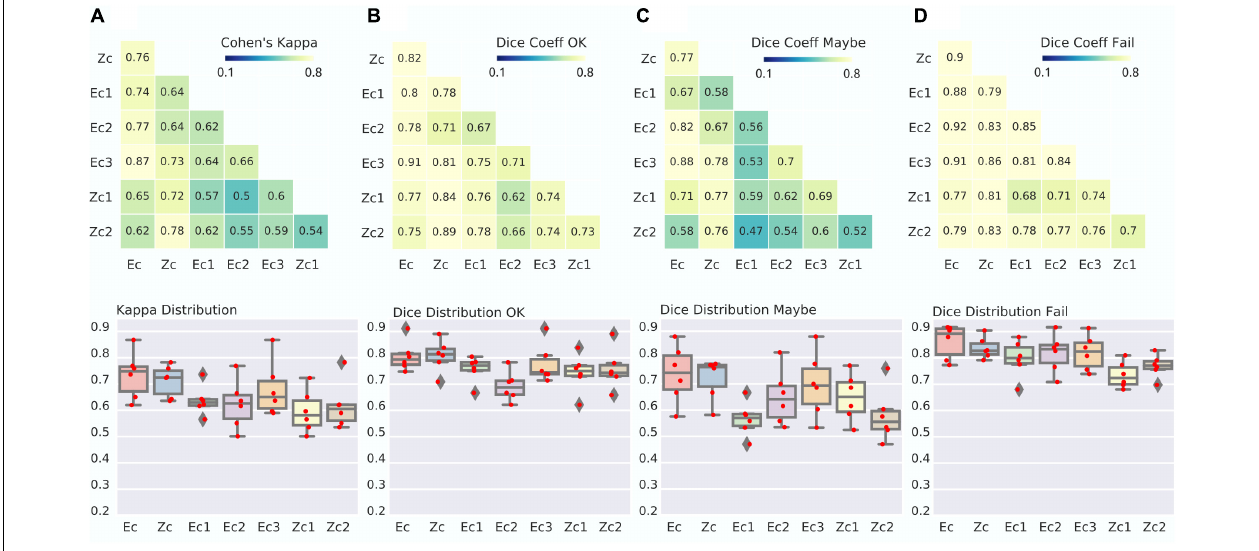
FIGURE 4 | Agreement between small panels of raters for both experts and Zooniverse panels. (A) Matrix of Kappa agreement between large panel consensus of experts (Ec), zooniverse users (Zc) and a small panel of expert (Ec1 = 3 rater, Ec2 = 3 rater, Ec3 = 3 rater) and small panel of Zooniverse raters (Zc1 = 20 rater, Zc2 = 21 rater) (top). The distribution of agreement is also presented (bottom). (B–D) Dice distribution between group consensus in the OK (B) , Maybe (C) , and Fail (D)